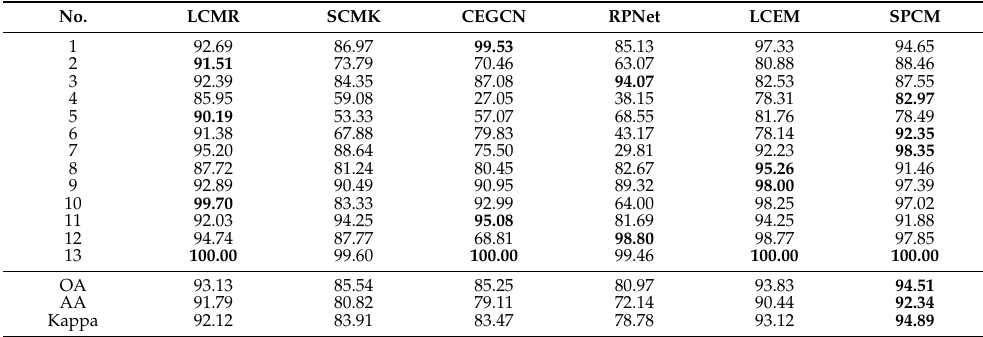
Table 2. Classification results obtained by LCMR, SCMK, CEGCN, RPNet, LCEM, and SPCM using 1% of the available labelled data for training with KSC data set. The best results are expressed in bold.